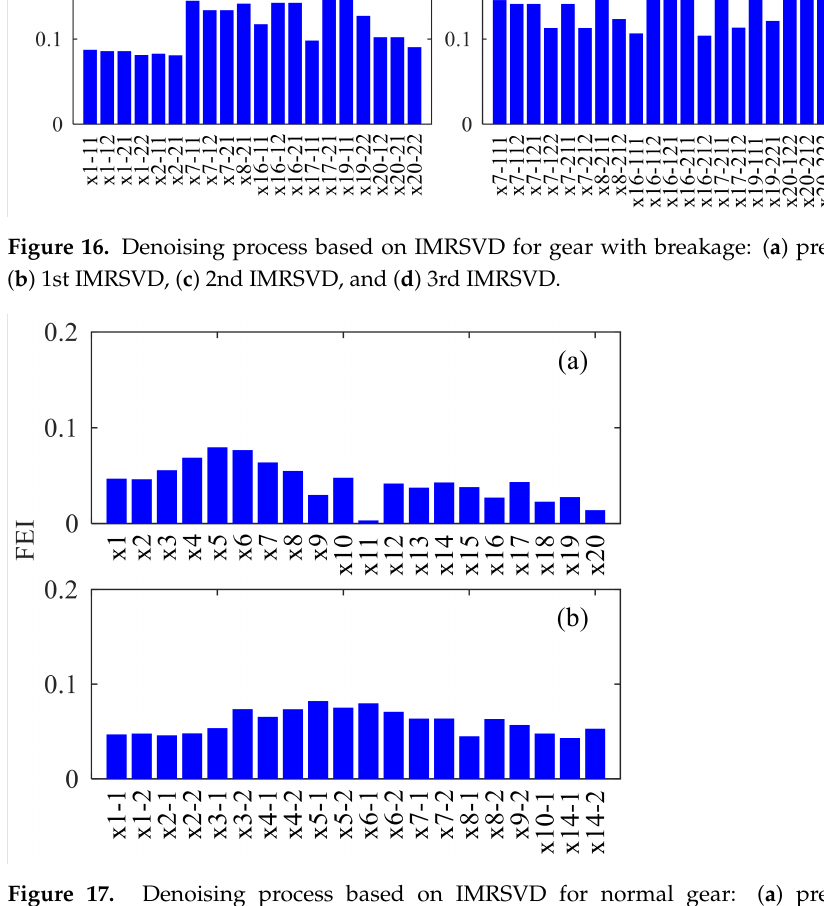
Figure 17. Denoising process based on IMRSVD for normal gear: ( a ) pre-decomposition, ( b ) 1st